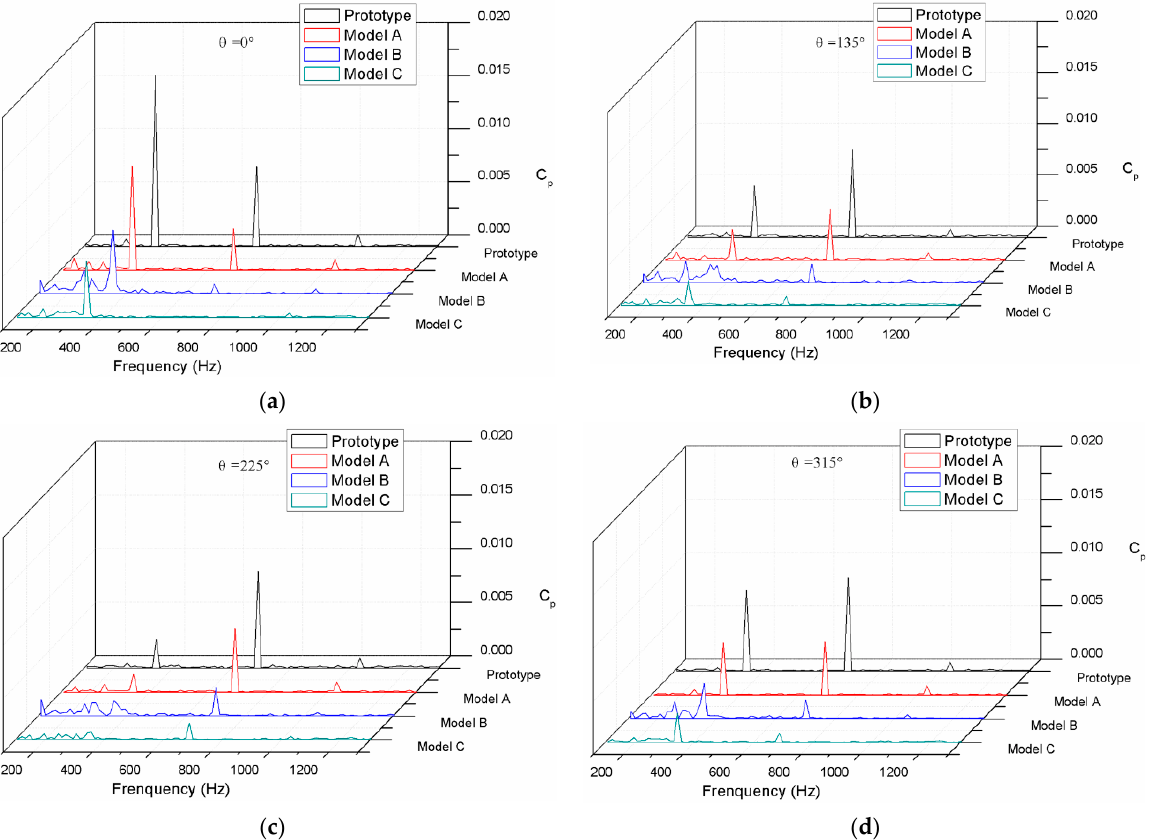
Figure 6. Pressure fluctuations spectra of the prototype and the modifications at monitor points: ( a ) θ = 0 ◦ ; ( b ) θ = 135 ◦ ; ( c ) θ = 225 ◦ ; ( d ) θ = 315 ◦ . According to Figure 6, the blade ‐ passing frequency 𝑓 (cid:3003)(cid:3017)(cid:3007) was 688 Hz where the am ‐